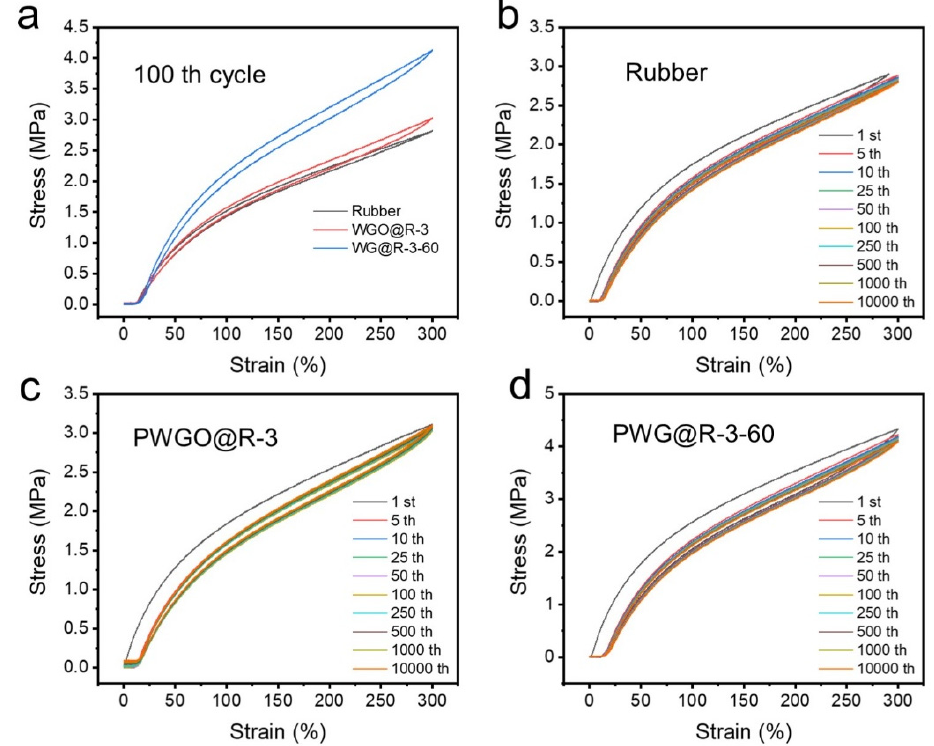
Figure 7. ( a ) Comparison of the mechanical cyclic properties of ( b ) rubber, ( c ) PWGO@R-3, and ( d ) PWG@R-3-60.